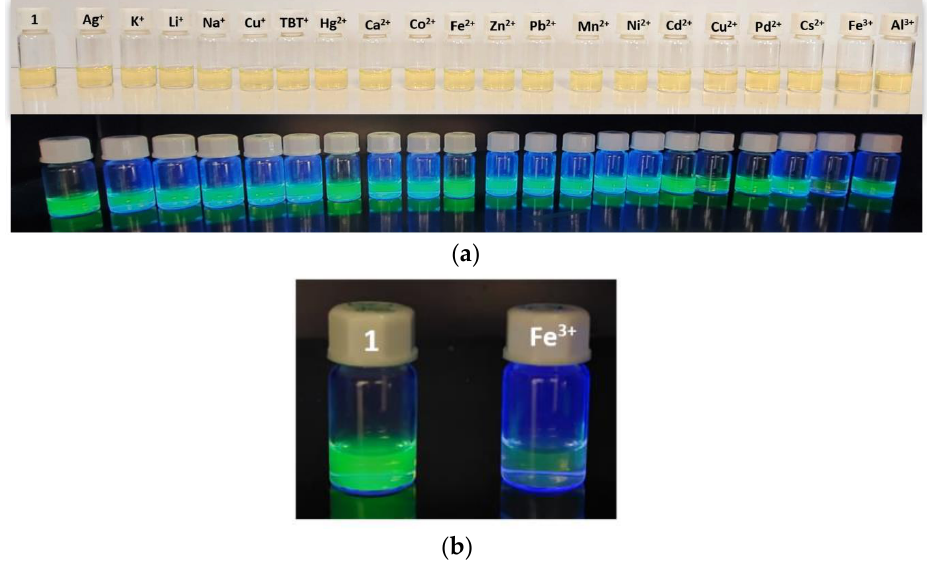
Figure 2. ( a ) Evaluation of BODIPY derivative 1 as colorimetric ( top ) and fluorimetric ( bottom ) chemosensor for several cations (50 equivalents) in acetonitrile solution. ( b ) Fluorescence quenching in the presence of Fe 3+ .